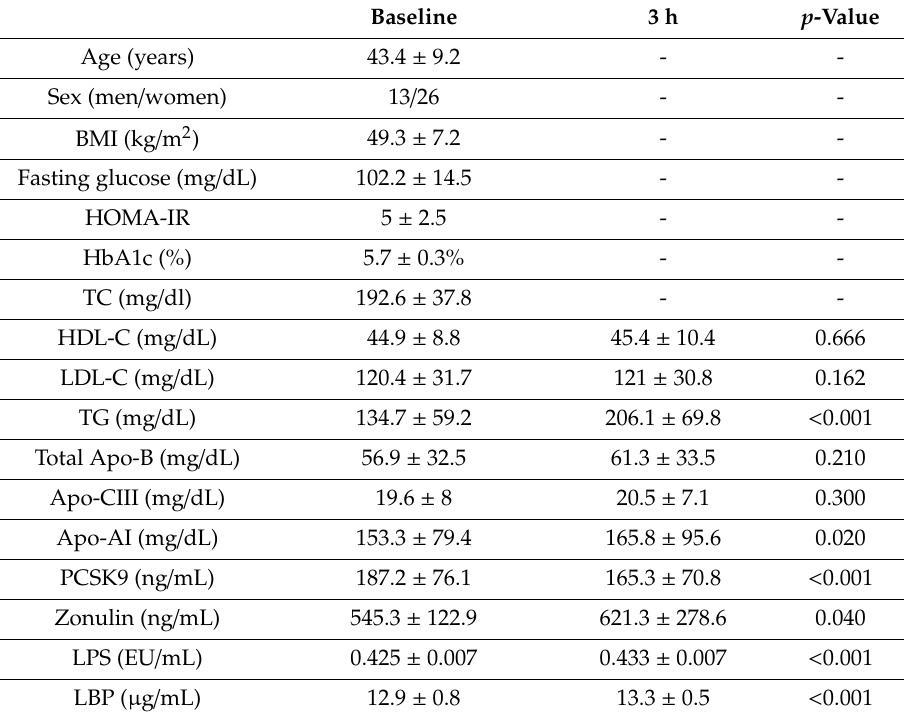
Table 1. Comparison between baseline and 3 h post fat load.